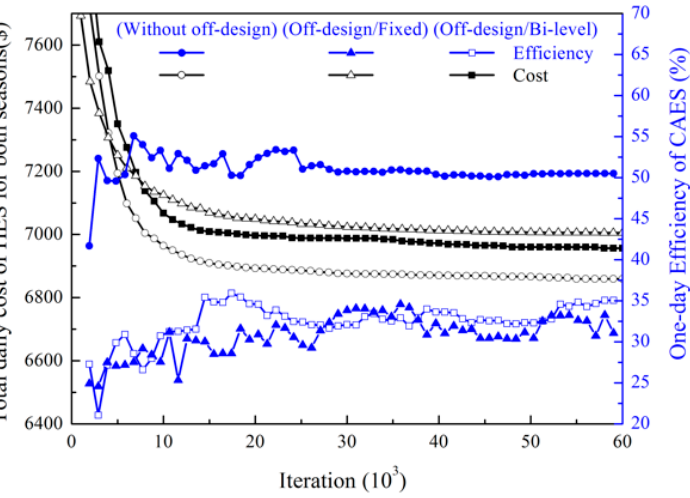
Figure 7. The optimization characteristics curves of different parameters in level II.